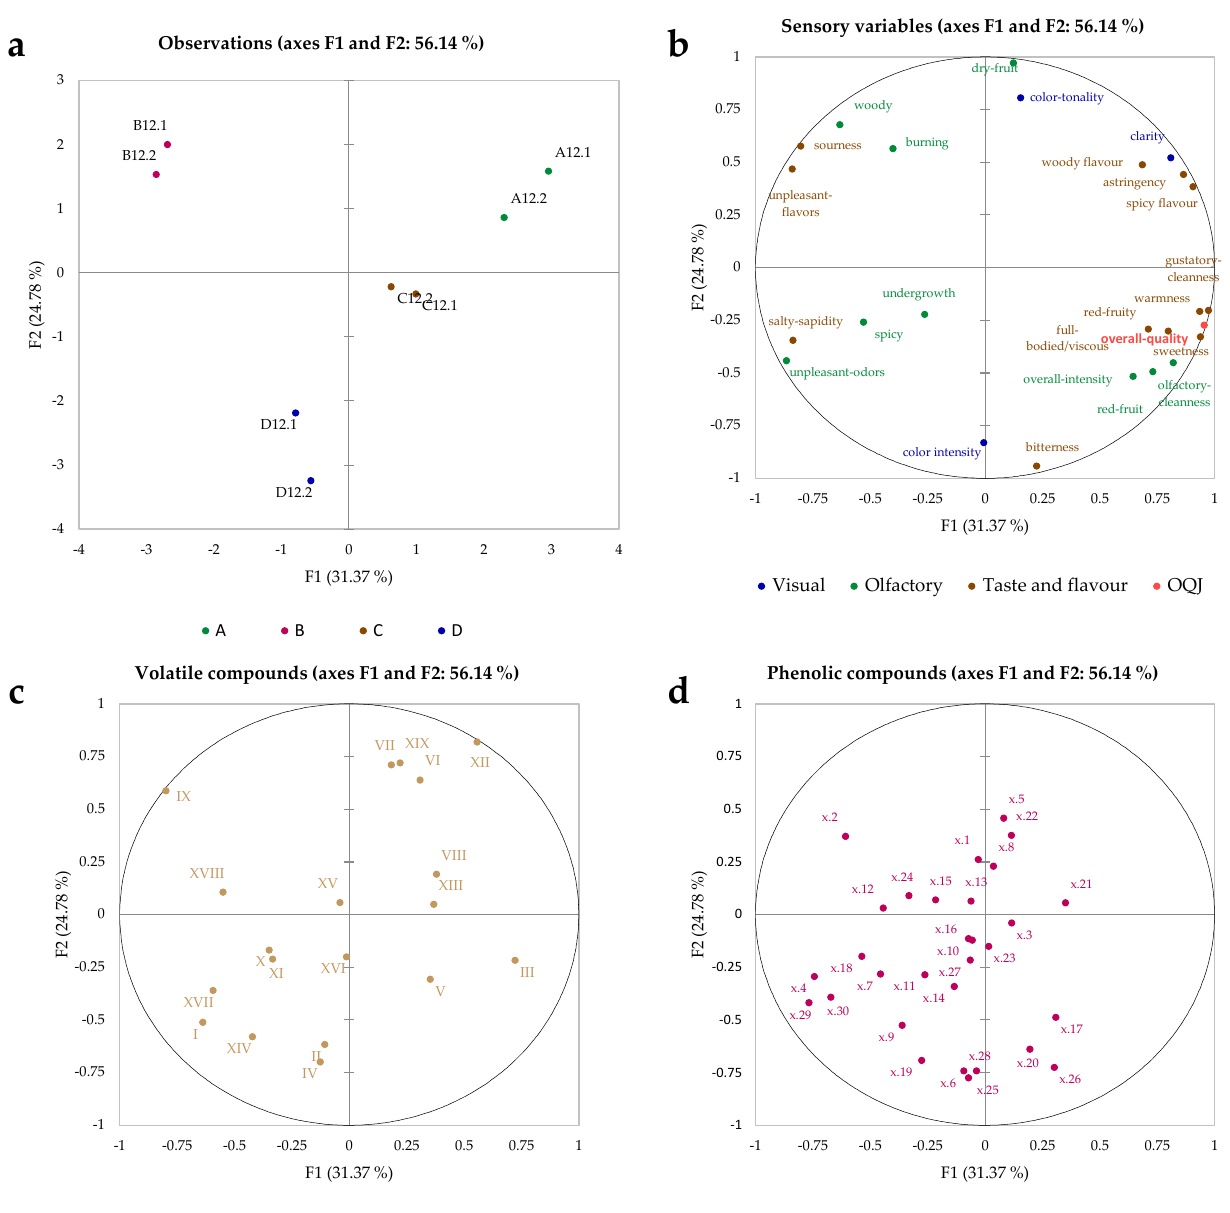
Figure 6. MFA plots on the T12 dataset: ( a ) observation plot, ( b ) sensory analysis variables plot, ( c ) volatile compounds variables plot, and ( d ) non-volatile phenolic compounds variables plot. T0, T1, T3, T6, and T12 indicate the storage month (0, 1, 3, 6, and 12) at which the samples were analysed. A, B, C, and D indicate the treatment (see Figure 1 for details).